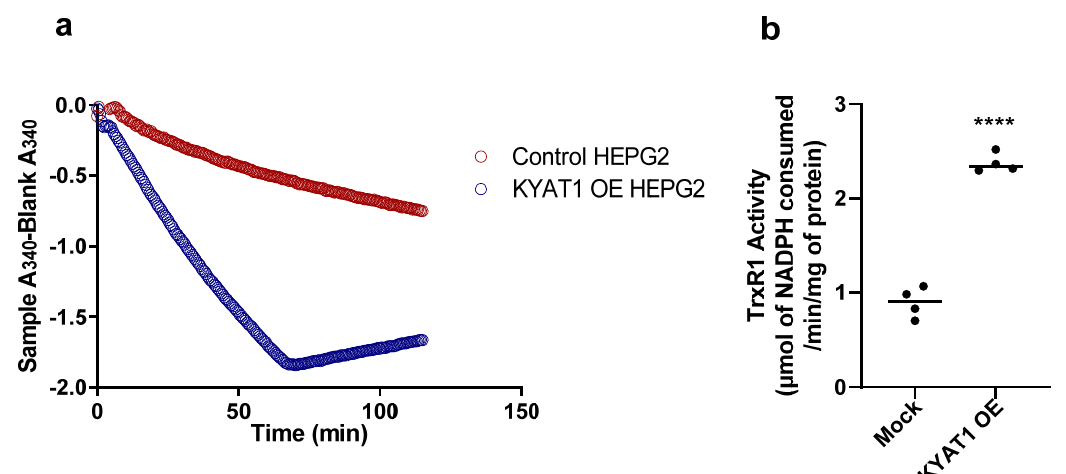
Figure 5. TrxR1 activity with KYAT1 over-expressed and mock transfected HEPG2 cells. ( a ) TrxR1 activity in cell lysates from control and KYAT1 over-expressed HEPG2 cells (20 µ g of control and KYAT1 over-expressed cell lysate). The 1 / 2T max velocity for control and KYAT1 overexpressed cell lysate was > 120 and 48.04 min. ( b ) The TrxR1 activity at the end of 30 min for control and KYAT1 over-expressed cell lysate is 0.20 and 0.52 nmol / min or 0.90 ± 0.16 and 2.31 ± 0.10 µ mol / min / mg of protein. Graph represent mean ± SD, statistical analysis performed with student t-test with 95% confidential interval (*** p < 0.001 compared with control).